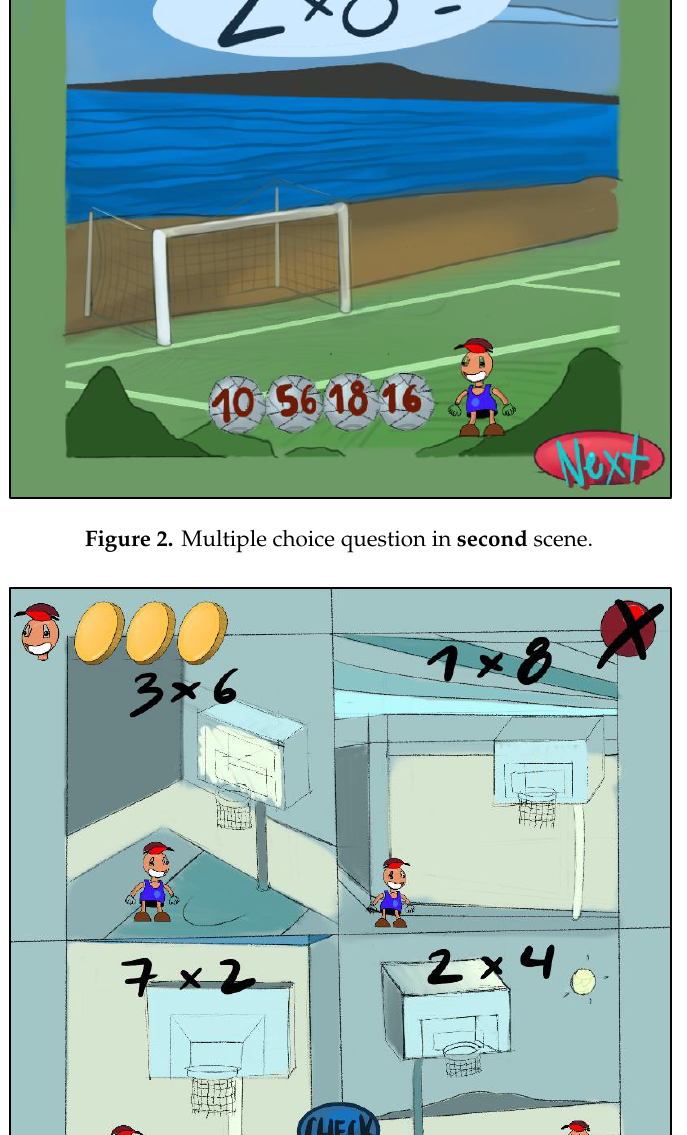
Figure 3. One-to-one matching question in third scene